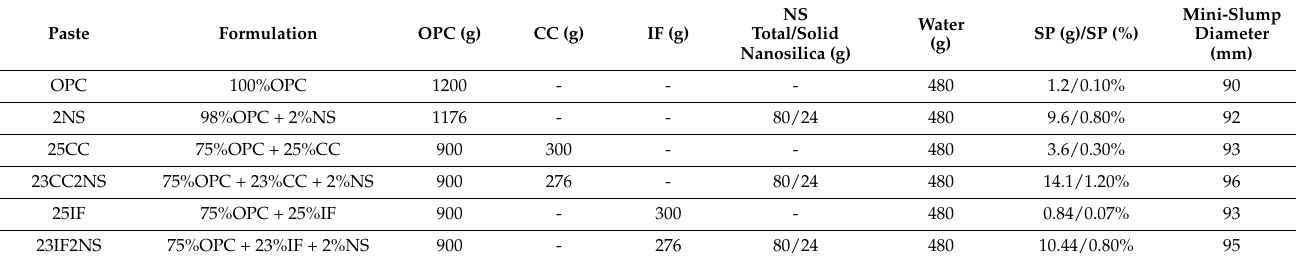
Table 2. Mass composition of the cement pastes.